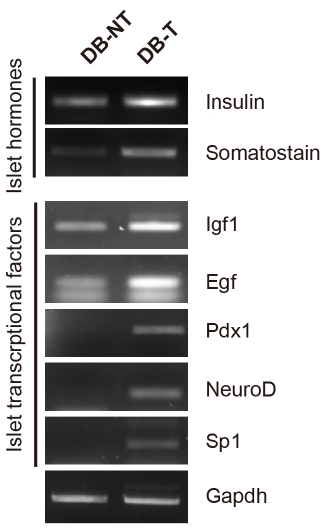
Figure 3. Effect of hydrolyzed SF on the transcriptional factors in the pancreatic islets. RT-PCR analysis of indicated transcriptional factors was performed in isolated pancreatic islets at 6 weeks after hydrolyzed SF treatment or not (DB-NT: db/db SF non-treated, DB-T: db/db SF treated).